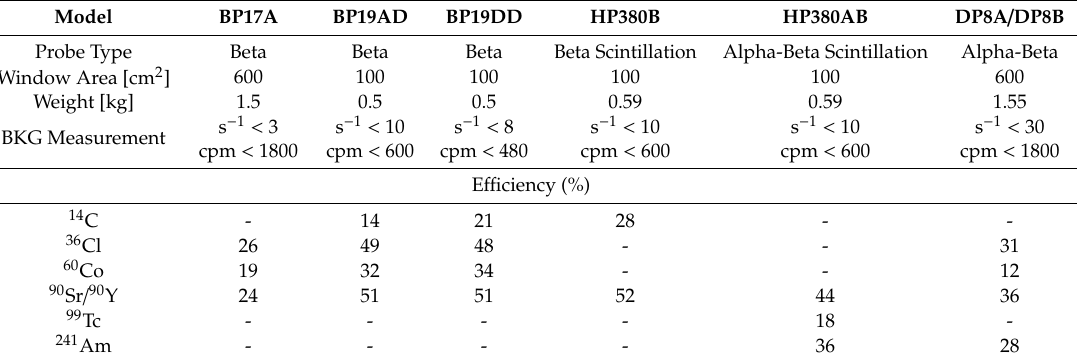
Figure 12. ( a ) HP-380AB alpha-beta scintillation hand probes [75] and ( b ) DP8A / DP8B alpha-beta probes [76]. Table 8. Compared characteristics of the probes from ThermoFisher.